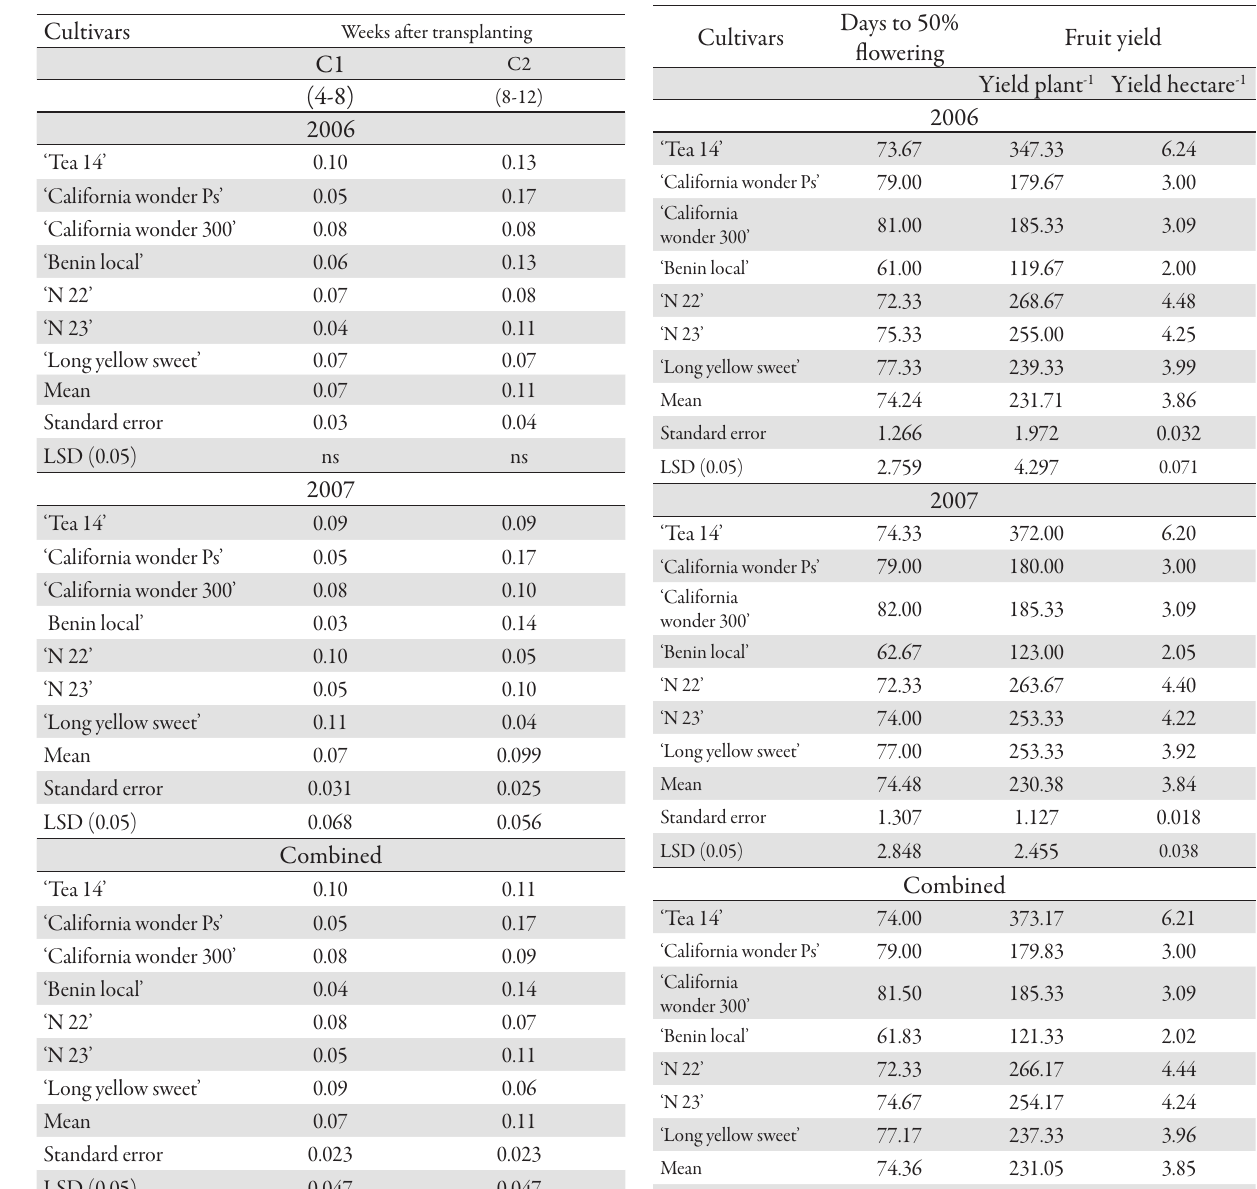
Tab. 6. Evaluation of some cultivars of C. annuum for